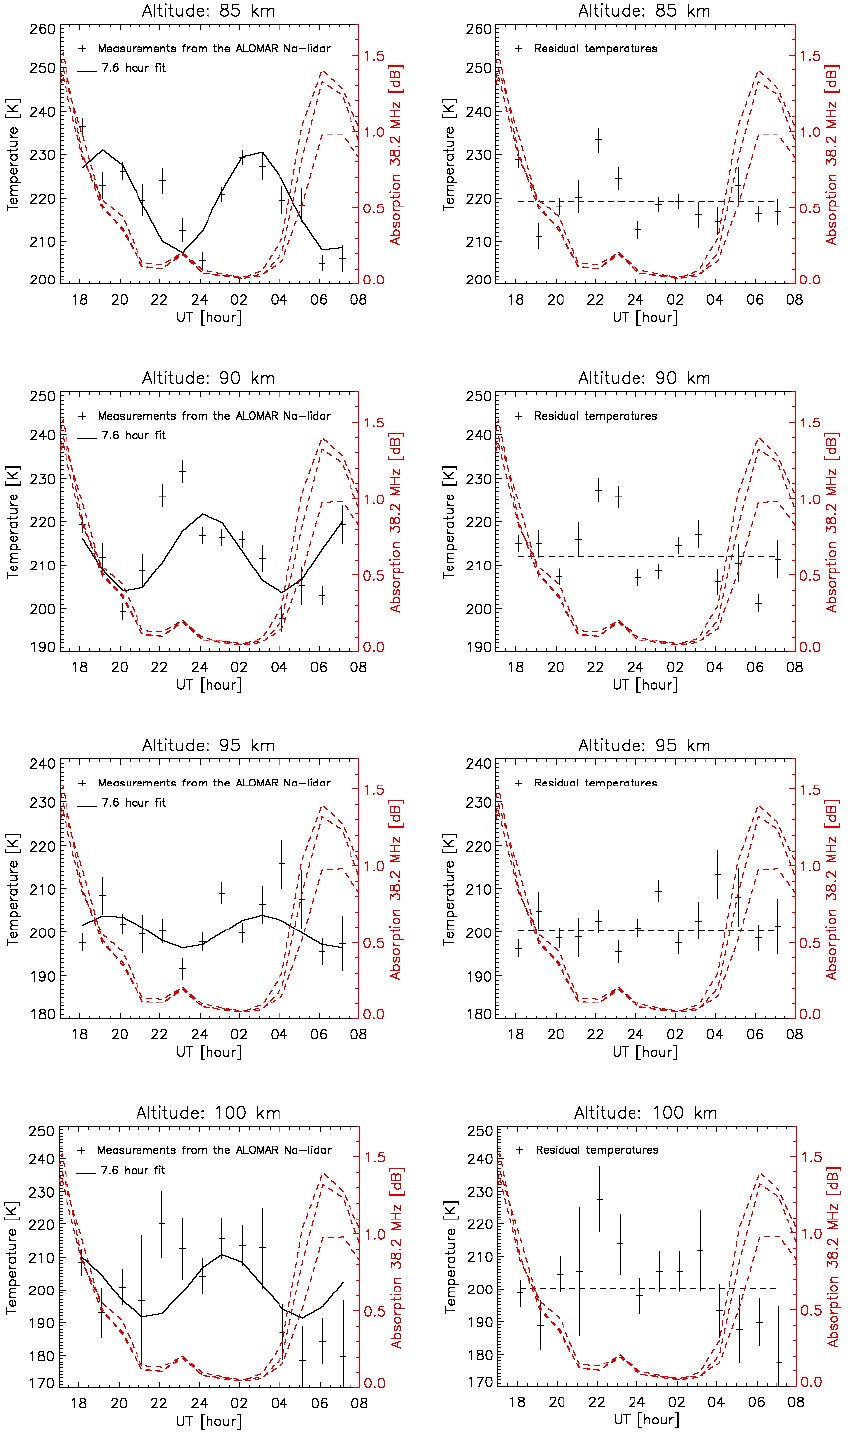
Fig. 11. The left column shows the hourly averaged temperatures, marked as crosses, from beam 2 in the ALOMAR Weber Na lidar on 21–22 January 2005 at 4 different heights. The solid black line shows a 7.6-h wave fit to the temperatures. The right column shows the temperature residuals when subtracting the wave fit. The red dashed lines show the cosmic radio noise absorption measured by IRIS in beam 8, 15 and